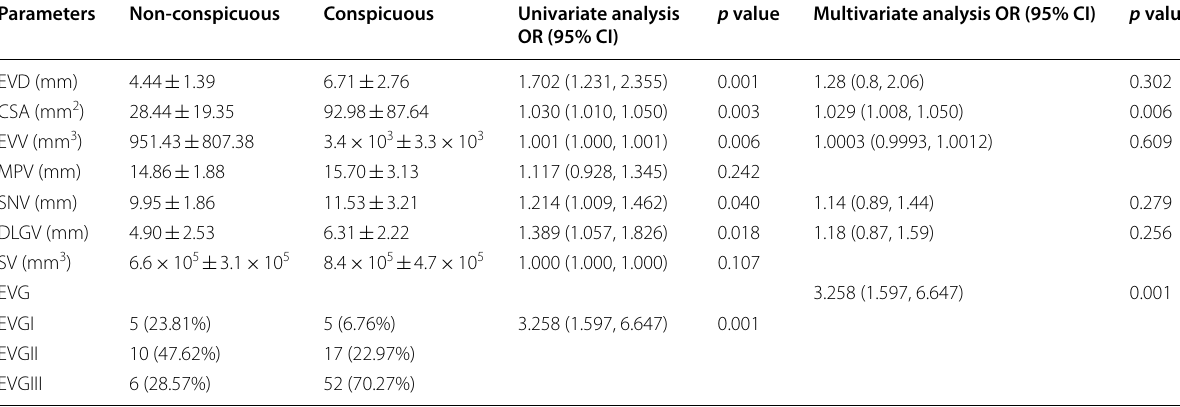
Parameters except EVG are expressed as mean standard deviation ± OR: odds ratio; CI: confidence interval, EV: esophageal varices, EVG: EV grade, EV diameter: EVD, cross-sectional surface area: CSA, EV volume: EVV, spleen volume: SV, diameter of left gastric vein: DLGV